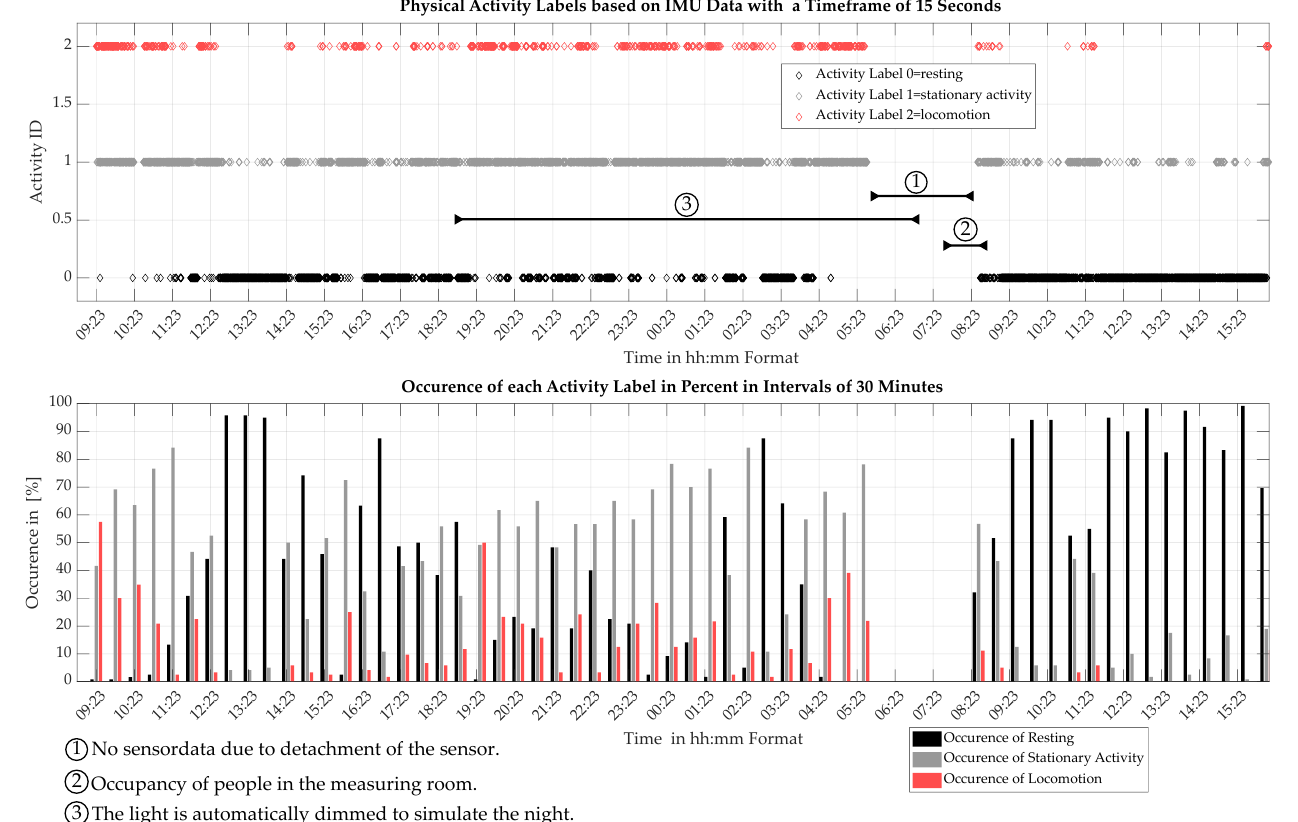
Figure 8. This figure shows the physical activity of the inhabitant of the husbandry cage over one and a quarter of a day. The activity labels are estimated from cage vibrations measured with an 9-axis IMU. The upper plot shows 6640 data points of activity labels which represent the activity patterns of 15 s intervals. The lower plot shows the occurrence of each activity in an interval of 30 min in percent. Special events are marked using